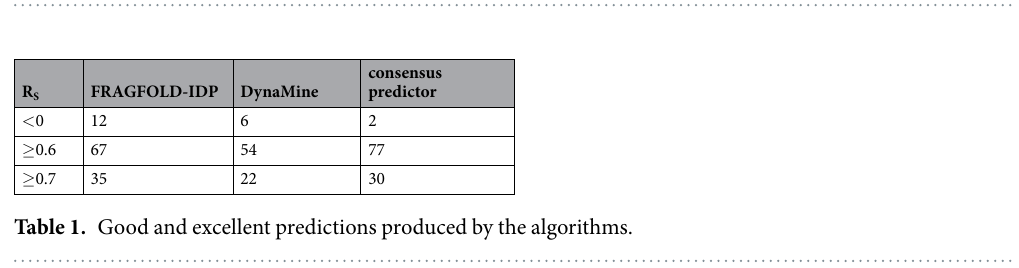
Figure 6. Comparison of FRAGFOLD-IDP, DynaMine and consensus predictor median R S values.